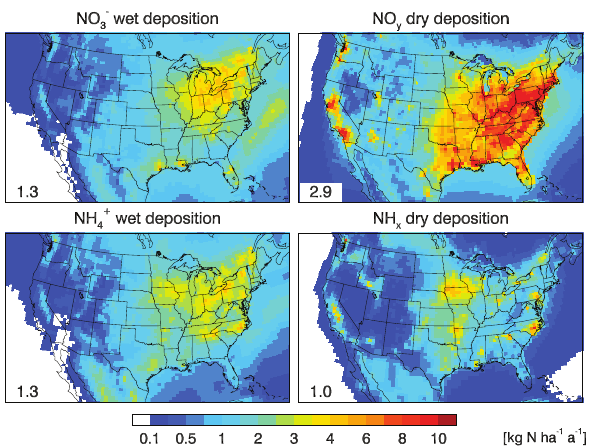
Fig. 7. Simulated annual total fluxes of NO − wet deposition, NO y 3 dry deposition, NH + wet deposition, and NH x dry deposition. Val- 4 ues are 3-year means for 2006-2008. Annual totals over the con- tiguous US from each process are shown inset in unit of TgNa − 1 .